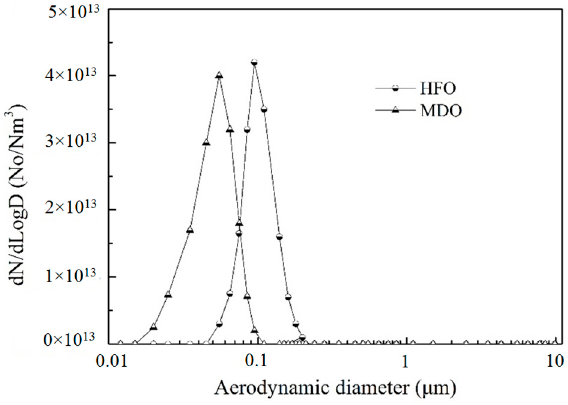
Figure 5. Particle amount size distribution in the exhaust gas from the engine.